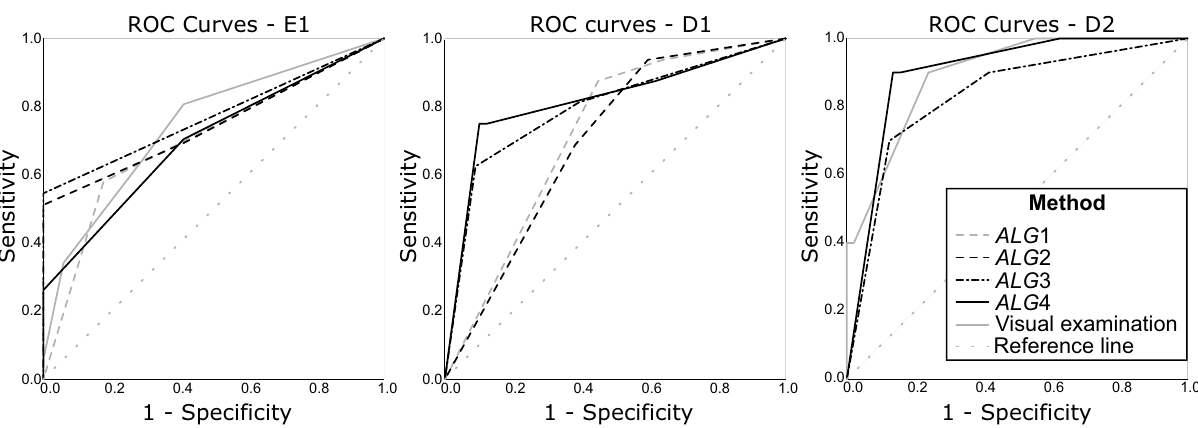
Figure 2. ROC curves corresponding to the four algorithms ( ALG1–ALG4 ) and visual assessment investigated in vivo at the histological levels E1, D1, D2. On the ROC curves, the Sensitivity values are plotted against the 1-Specificity values. The curves closer to the top-left corner indicate a better diagnostic performance, while curves closer to the reference diagonal line indicate inferior diagnostic